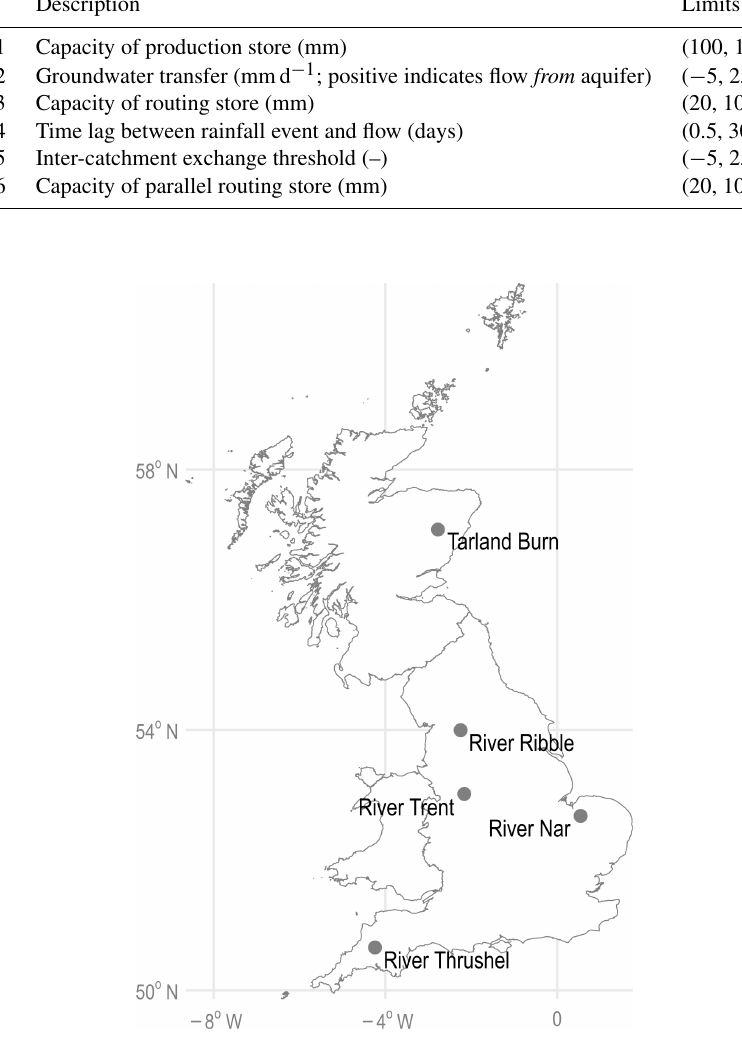
Figure A1. Distribution of the case study catchments across the